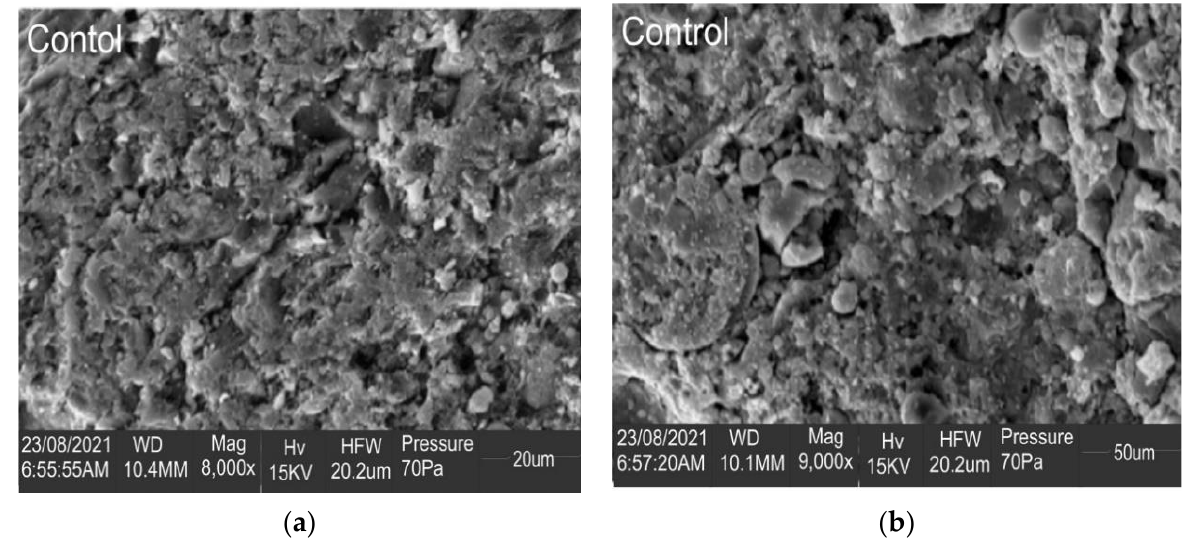
Figure 9. SEM of control mortar mix ( a ) at 7 days ( b ) at 28 days.